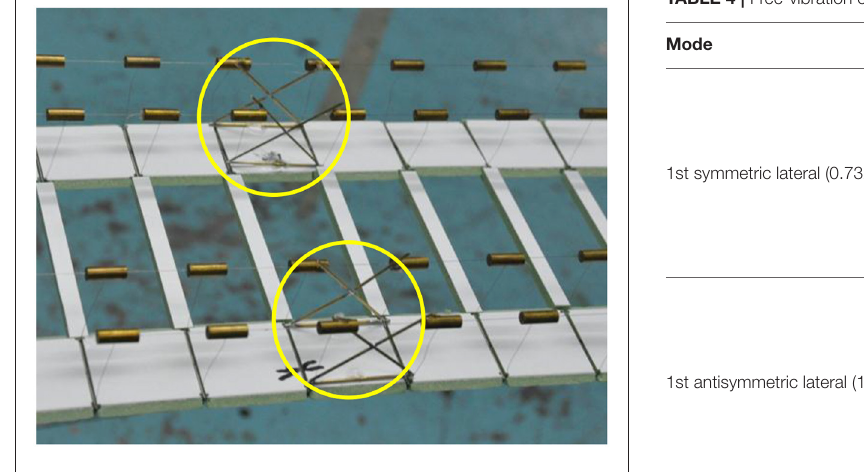
FIGURE 16 | Central buckle.